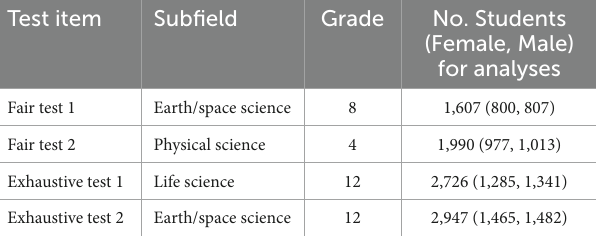
TABLE 1 Basic information of the testlets investigated in this